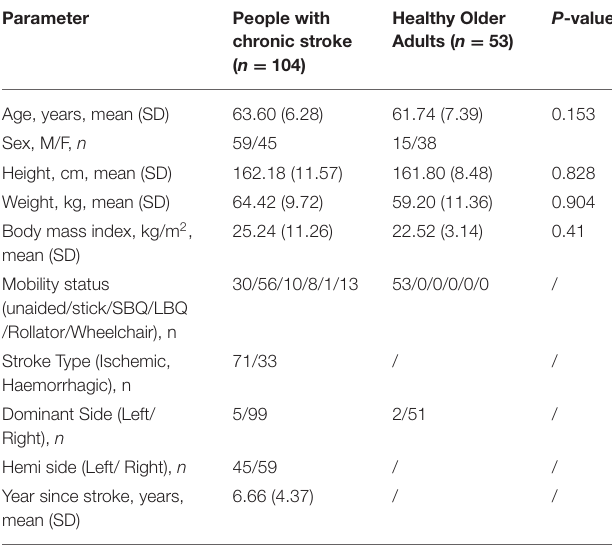
TABLE 1 | Demographics of people with chronic stroke and healthy older adults.